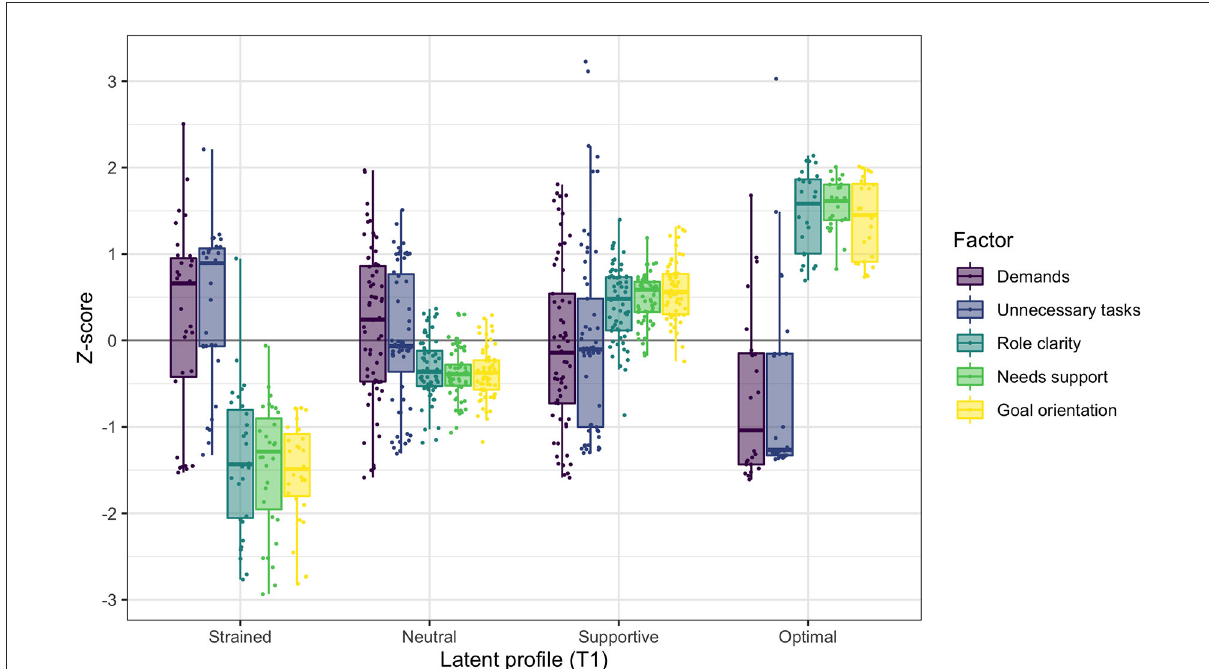
FIGURE1 Co-care profiles at T1, illustrated with boxplots and individual data points of the co-care factor z scores ( M = 0, SD = 1).